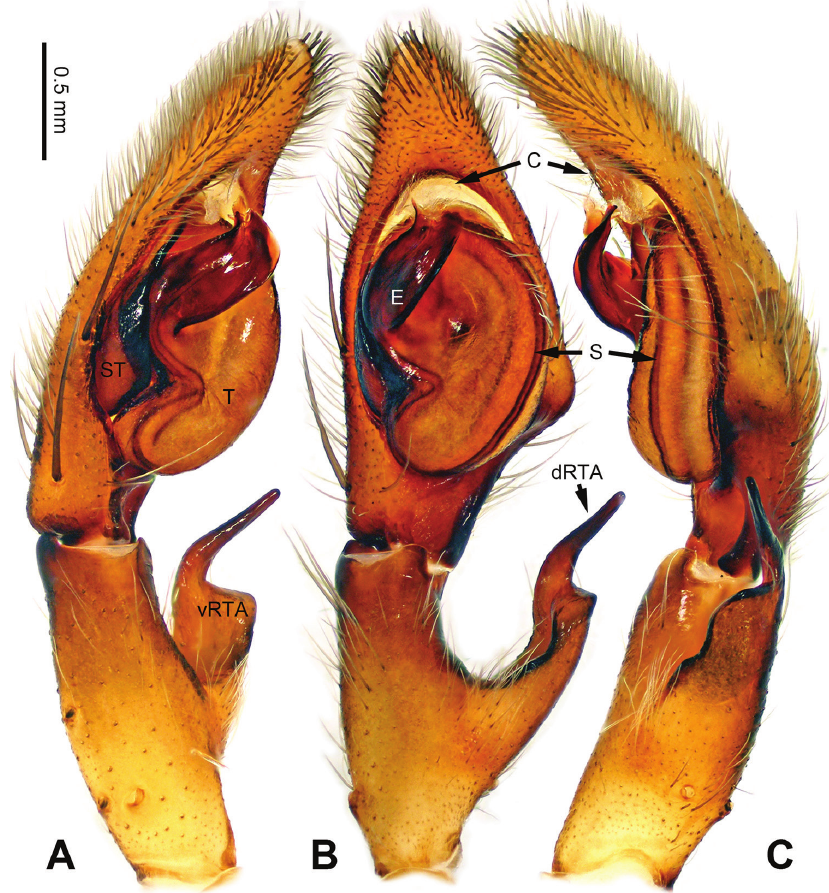
Figure 34. Pseudopoda zixiensis Zhao & Li, sp. n., left palp of male holotype. A Prolateral view B Ventral view C Retrolateral view. Scale bar equal for A, B, C